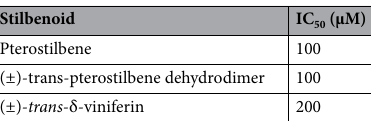
Table 4. Stilbenoids IC 50 on Caco-2 cell